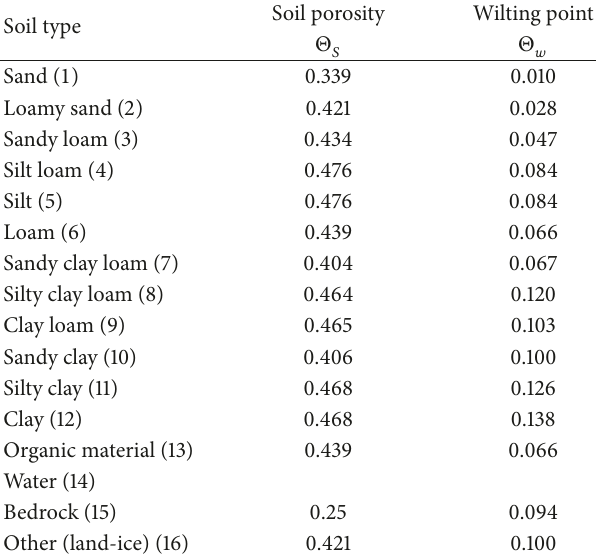
Table 1: The soil moisture values used to replace Control soil moisture values in each wrfinput file with their associated soil type. Soil porosity values are for Moist simulations, and wilting point values replace soil moisture values in the Dry simulations. Numbers next to each soil type are the corresponding WRF soil type classifications used within the wrfinput